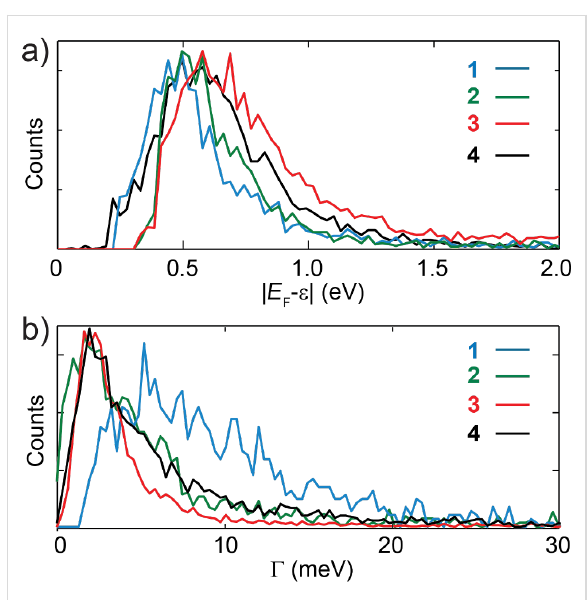
Figure 6: (a) One dimensional histograms of the injection barrier, for molecules 1 – 4 , extracted from the single level model (linearly binned with 36 bins/eV). (b) One dimensional histograms of the electronic coupling linearly binned with 3 bins/meV.